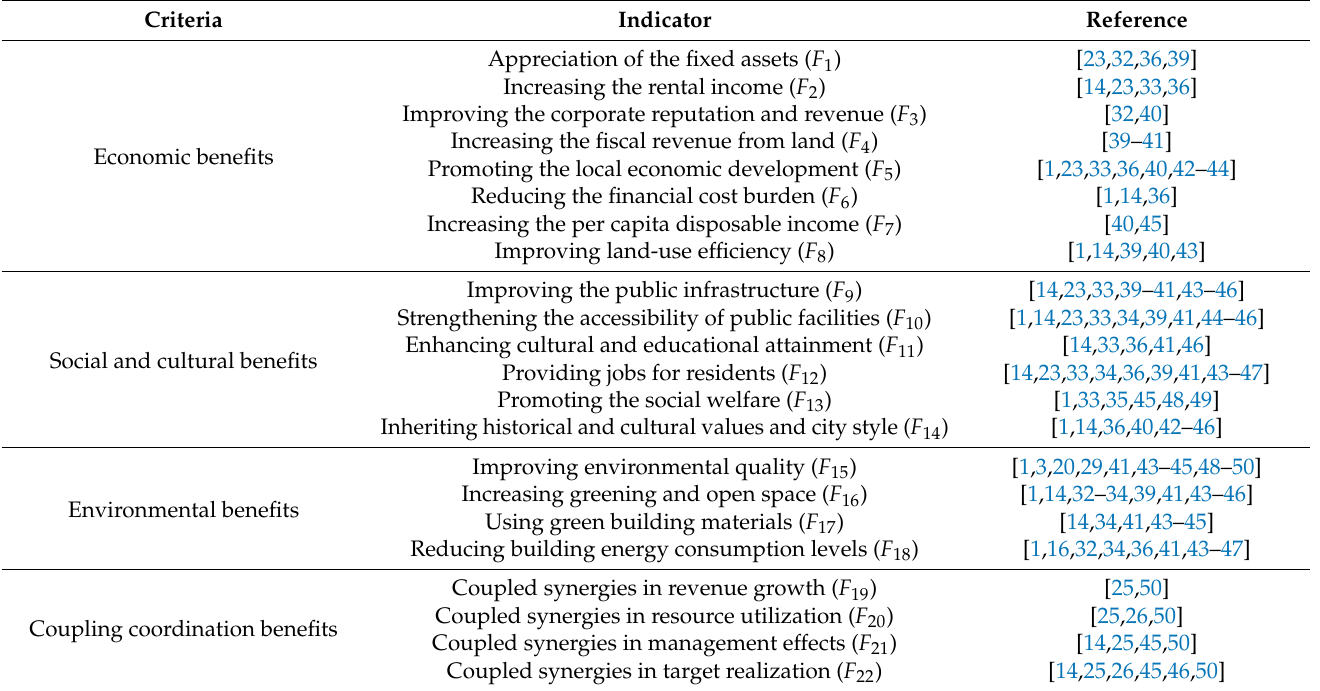
Table 1. Indicators for comprehensive benefit evaluation of urban renewal projects on the area